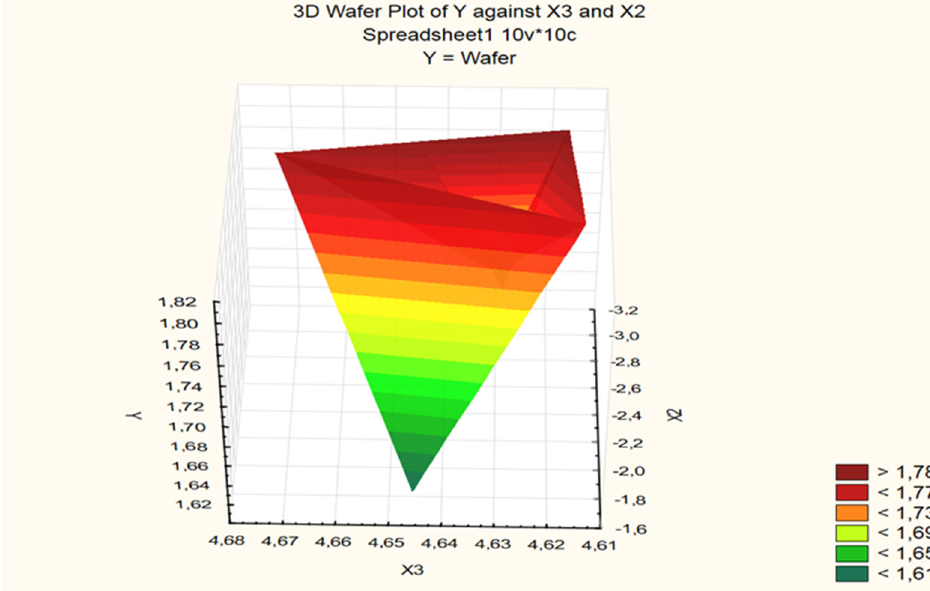
Figure 5. A 3D diagram of the surface of the production function model (calculated by the authors).